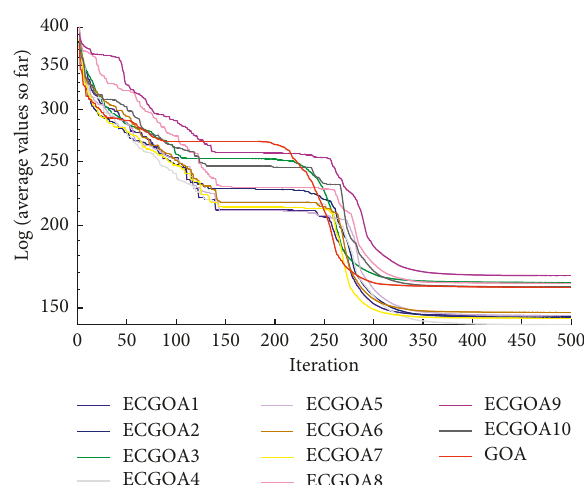
Figure 6: Convergence curve for multimodal function 7 (30-D).